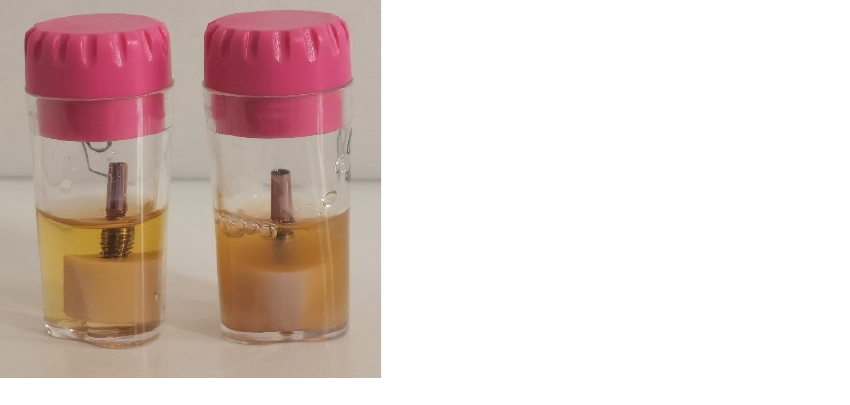
Figure 10. Samples placed into the nutrient solution during the follow-up. Right = turbidity of the broth as a sign of bacterial penetration; Left = no contamination.